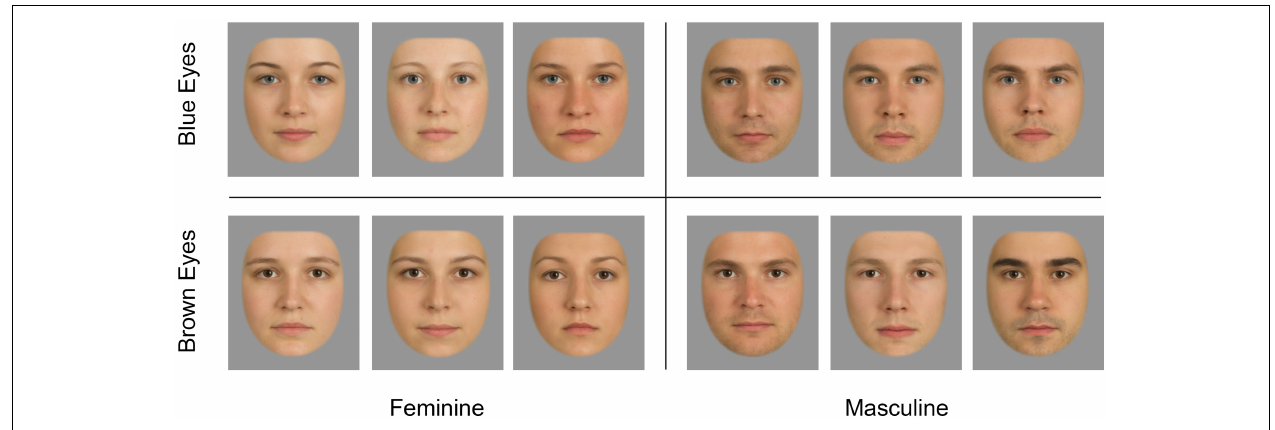
FIGURE 1 | Morphed faces served as stimuli in Experiments 1 and 2. Each face was a composite produced by averaging three natural faces using image processing software.There were two versions of each face, one with blue